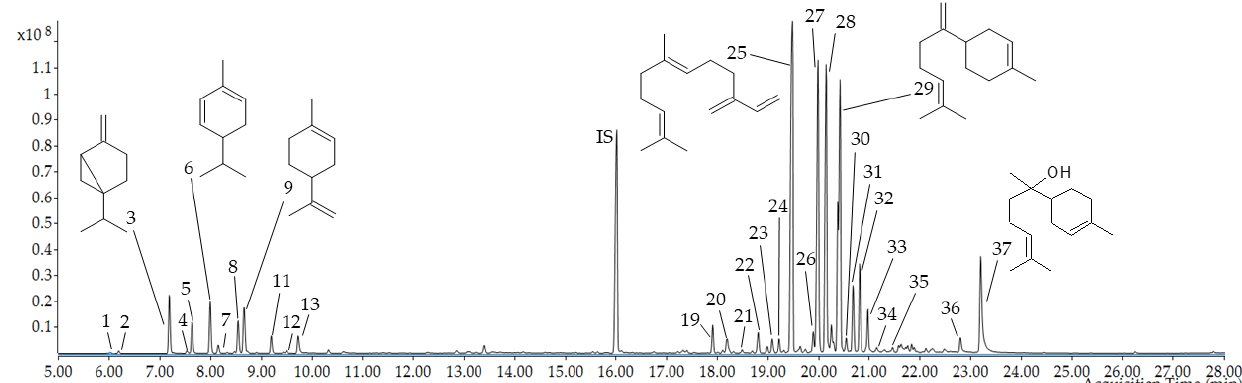
Figure 7. HS–SPME/GC–MS chromatogram of volatile compounds in E. senticosus fruits. The numbers correspond to the compounds in Table 2; IS—internal standard. Table 2. Percentage of volatile compounds identified by HS–SPME/GC–MS in E. senticosus fruits (% ± SD) (RT—reten- tion time, RI calc—retention index, calculated, RI lit—retention index, literature. Internal standard—2-undecanone. All analyses were performed in triplicate).